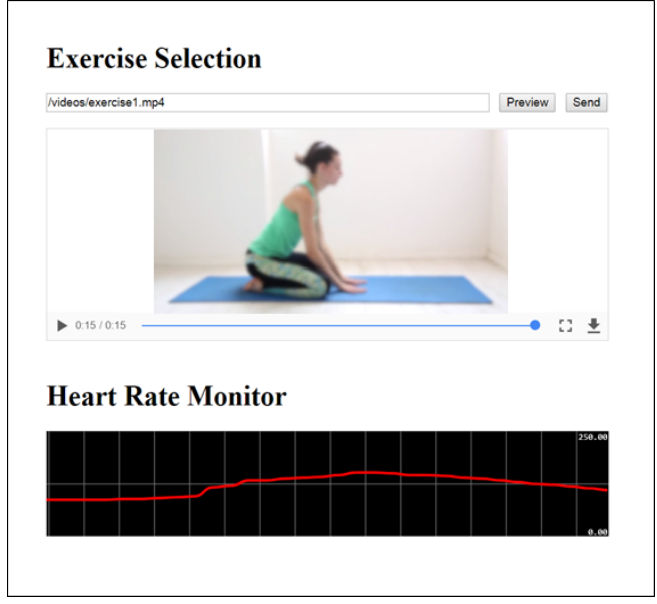
Figure 7. UI of the personal